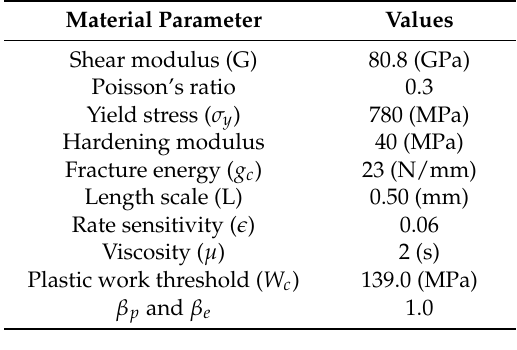
Figure 8. The U-notched plane strain sample: ( a ) the geometry and associated dimensions in mm and ( b ) the finite element discretization.